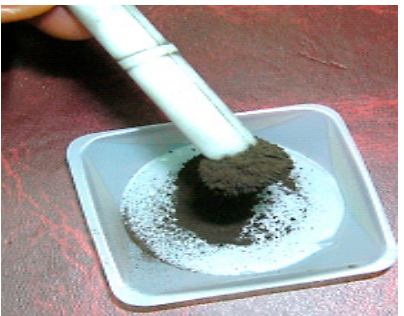
Figure 1. Magnetic performance of the fabricated magnetic amine-functionalized silica gel nano-hybrid material (MANSG).